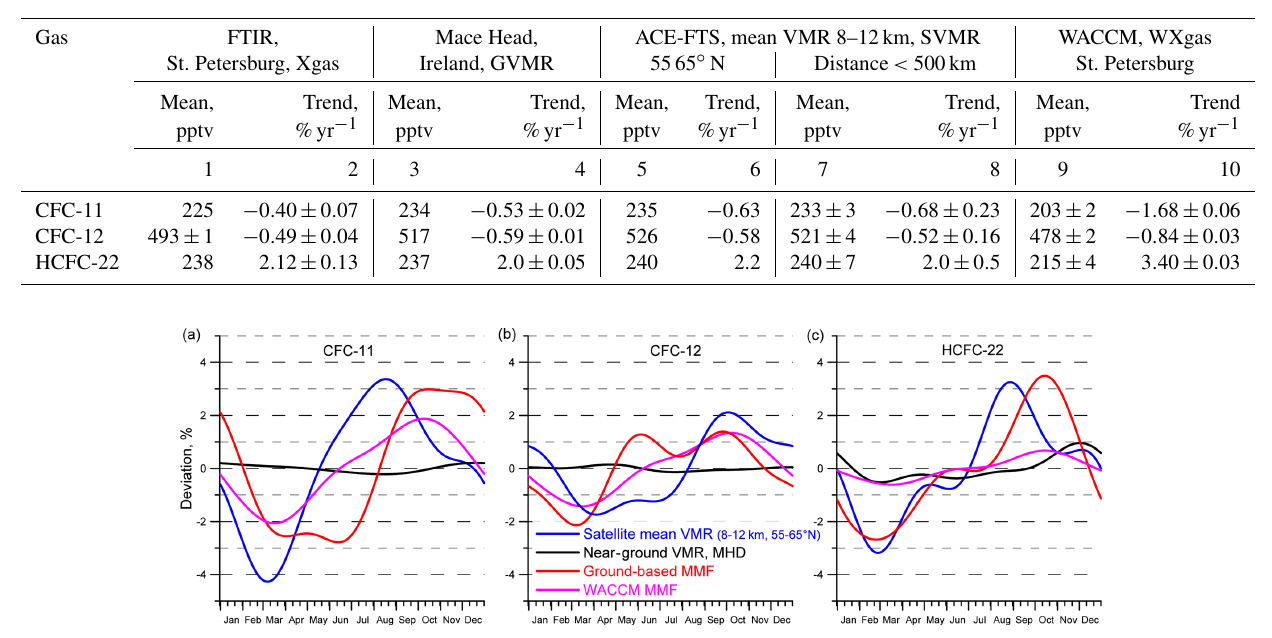
Table 6. The means and the trends estimates of the FTIR Xgas, GVMR, and SVMR measurements, and the WXgas. If the width of the confidence interval is not specified, then it is less than the last significant digit.